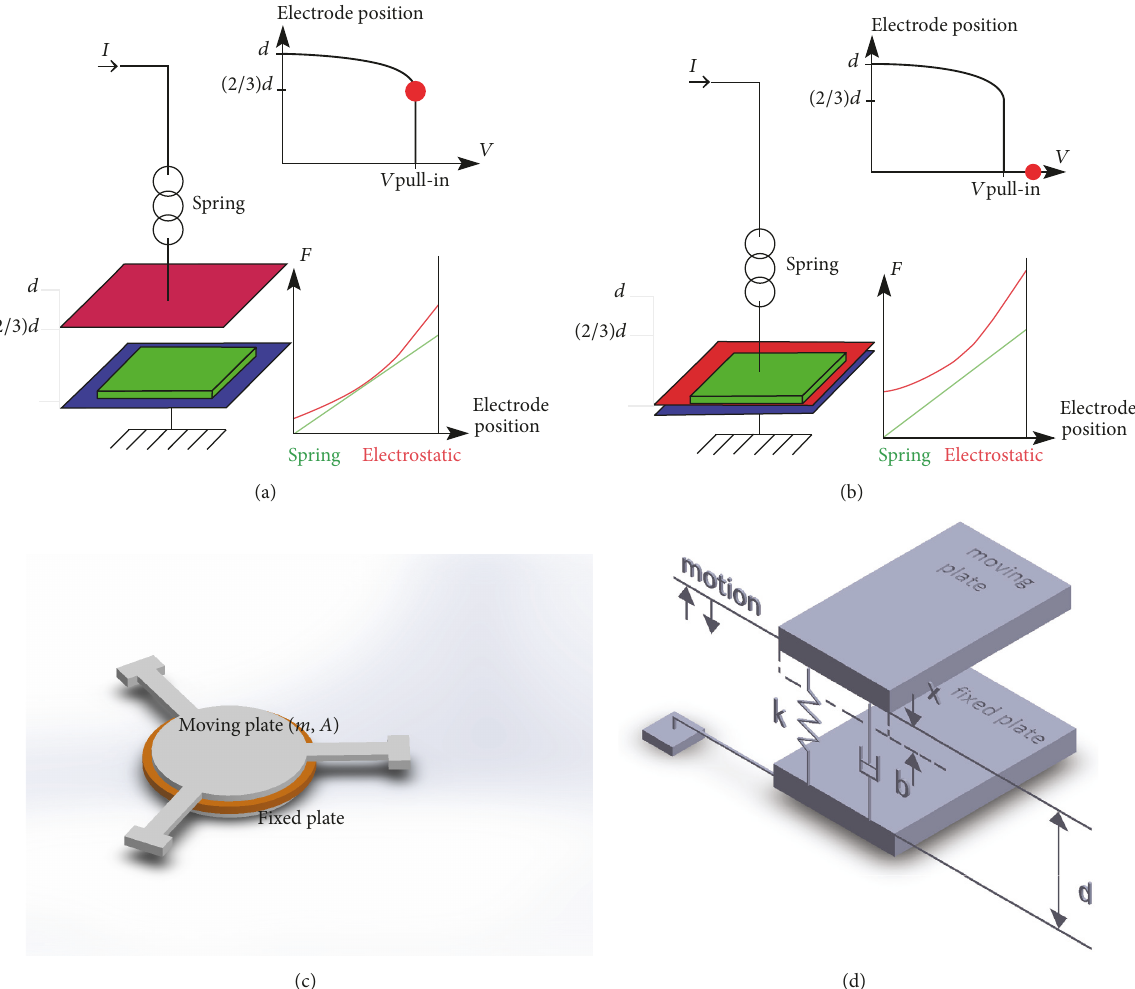
Figure 1: MEMS tunable capacitor; (a) its model and pull-in point: pull-in point transpires when movable electrode reaches one-third of its initial distance to fixed electrode; (b) tunable capacitor mislays its stability beyond pull-in voltage; (c) top plate puts in motion in a piston way; (d) lumped model of the MEMS tunable